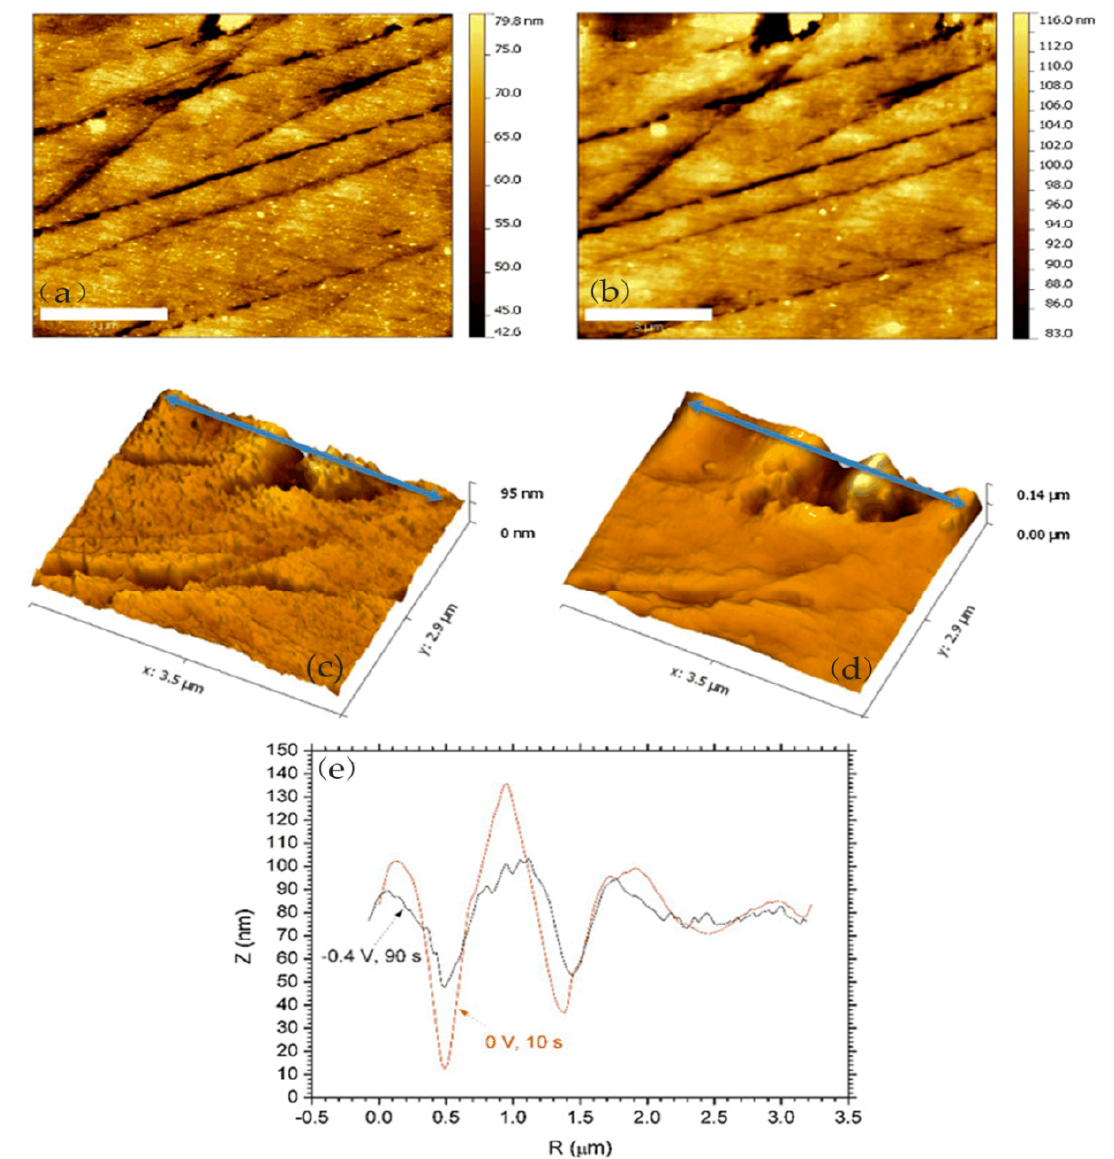
Figure 3. The in situ AFM images of AA 2024: ( a ) 226 min, − 0.4 V / Ag / AgCl / KCl sat , 90 s; ( b ) 328 min, 0 V / Ag / AgCl / KCl sat , 10 s. ( c , d ) The corroding sites on top of the images ( a , b ) as three-dimensional (3D) images. ( e ) The profile lines measured over the corroding intermetallic particle. Reprinted with permission from Reference [35]; copyright 2016 Elsevier